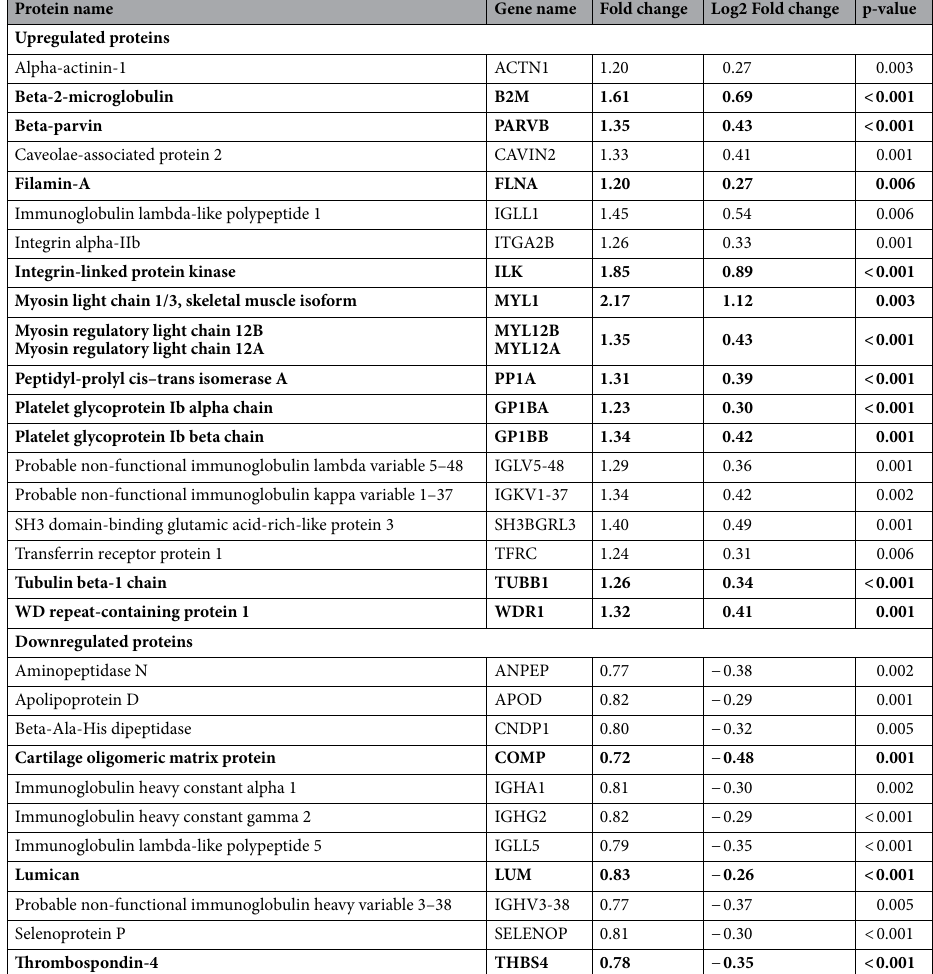
Table 2. Significantly dysregulated proteins in POTS identified using data-independent acquisition (DIA) label-free quantification mass spectrometry. Label-free protein quantification identified 30 significantly dysregulated proteins in POTS, 19 upregulated and 11 downregulated proteins using a cutoff log2 fold change set to 1.2 and false discovery rate (p-value) of < 0.05. Proteins in bold displayed a strong protein–protein interaction in the STRING pathway analysis (Figs. 2,